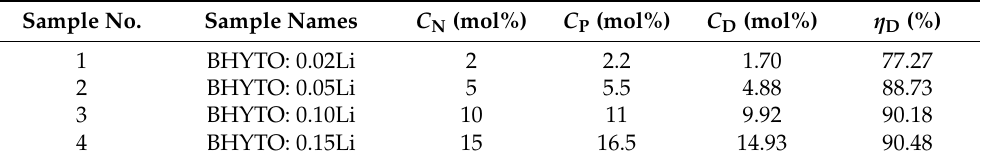
Table 1. The results of ICPMS measurement for Li content in BHYTO: x Li samples ( x = 0.02, 0.05, 0.10, and